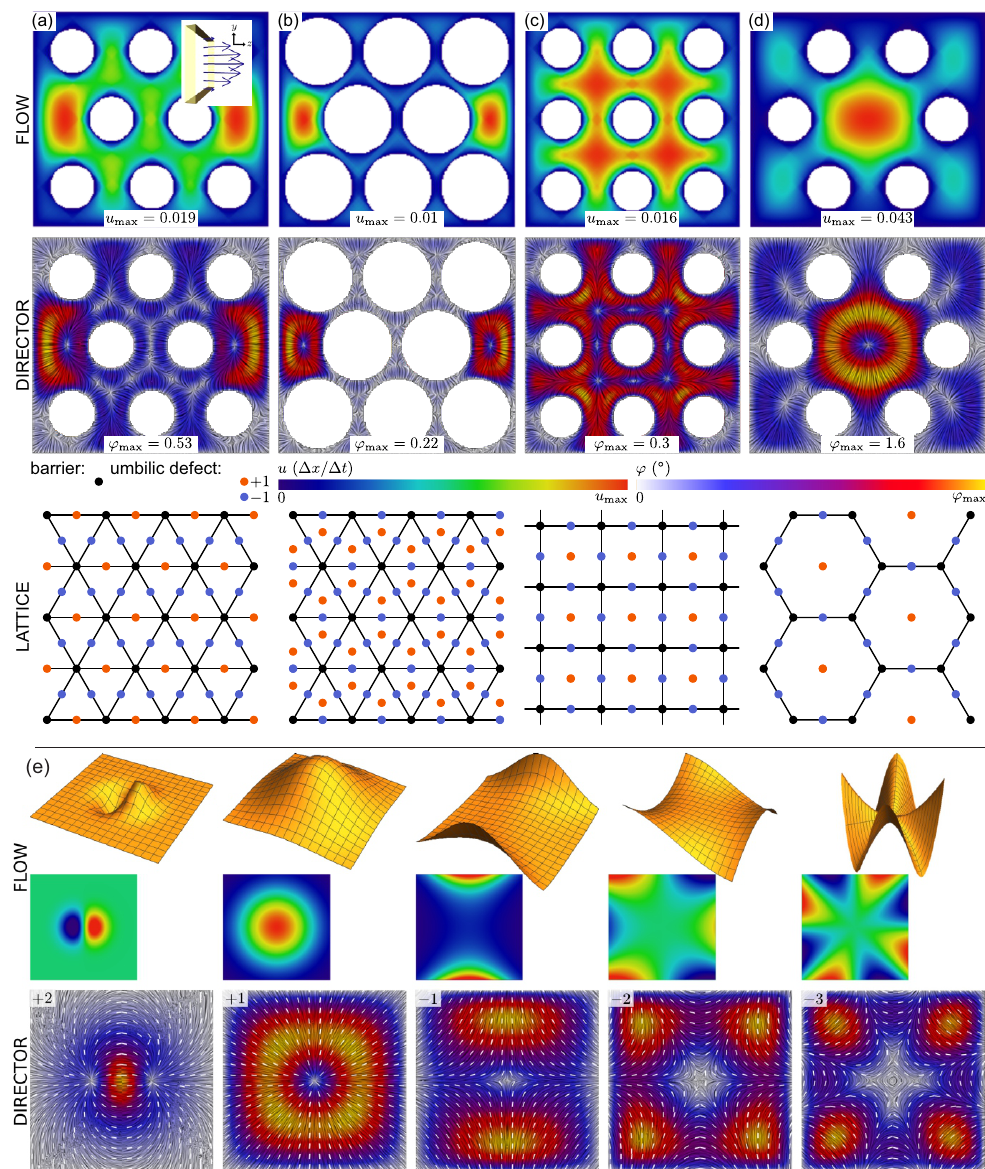
Figure 7. Porous nematic microfluidics as generator for umbilic defect lattice structures. Porous mi- crochannels with cylindrical barriers are arranged into ( a , b ) triangular, ( c ) square, and ( d ) hexagonal lattices, creating: ( a ) a triangular lattice of + 1 umbilics and a rectangular lattice of − 1 umbilics form, ( b ) a hexagonal lattice of + 1 umbilics and a Kagome lattice of − 1 umbilics, ( c ) a square lattice of both + 1 and − 1 umbilics, and ( d ) a triangular lattice of + 1 umbilics and Kagome lattice of − 1 umbilic. The bottom panels show generalization of the observed structures. ( e ) Generation of umbilic defects of variable (high) umbilic strength by flow peaks and flow saddle points. A local peak in the velocity field generates a + umbilic, and flow saddle generates a − umbilic. The image is reprinted and adapted with permission from the reference [143]–Copyright (2016) Taylor &